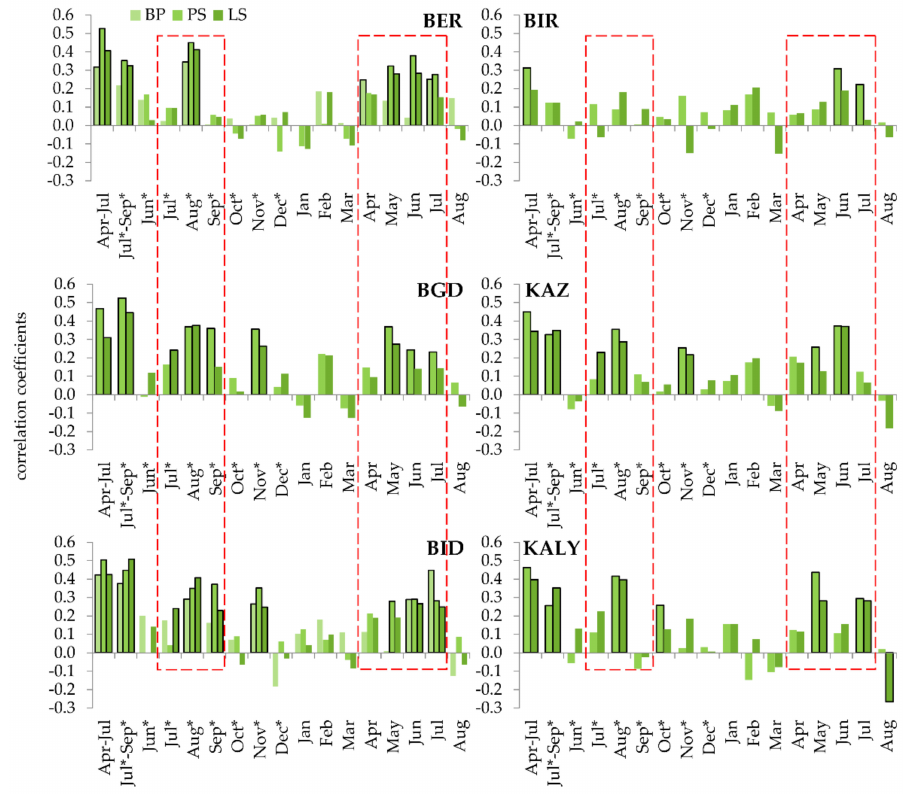
Figure 2. Correlation coefficients of local residual tree-ring width chronologies with regional SPEI (1936–2018) for individual months and longer intervals (current April–July and previous July– September) of growth season. Dashed rectangles represent intra-seasonal intervals with maximum integral positive response. Bars representing significant correlation coefficients ( p < 0.05) are outlined by black line. BP— Betula pendula Roth., PS— Pinus sylvestris L., LS— Larix sibirica Ledeb.; * months of the previous